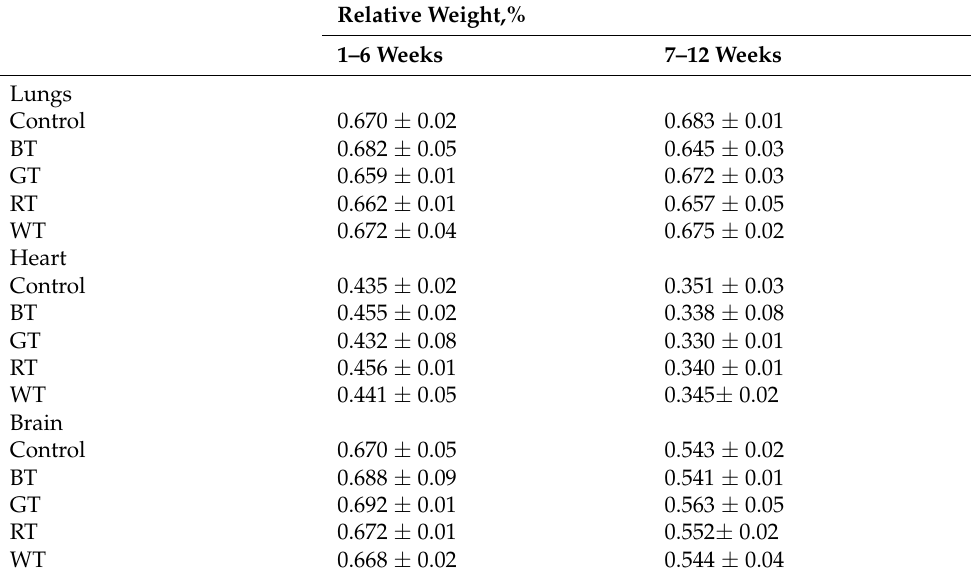
Table 6. Experiment 2—Relative weight of lungs, heart and brain for 6 and 12 weeks of exposure (mean ± SD). Relative Weight,% 1–6 Weeks 7–12